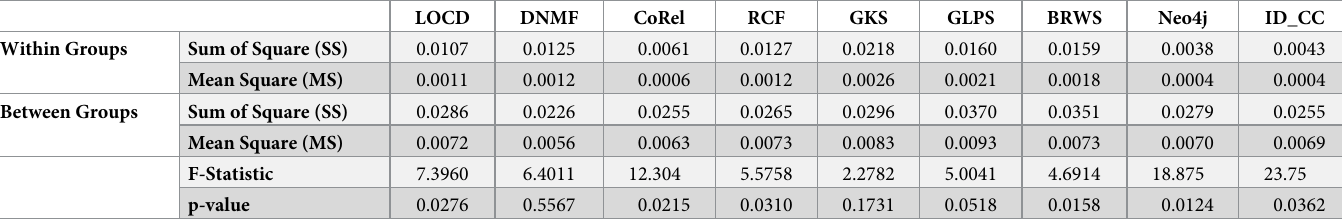
Table 4. One way ANOVA table for the overall average values of the F1-score tests.